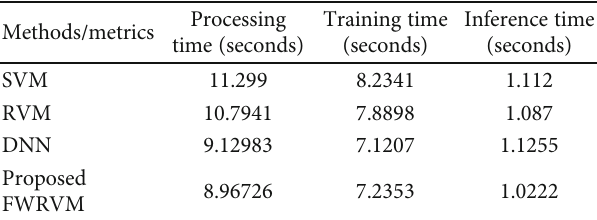
Table 5: Time comparisons.